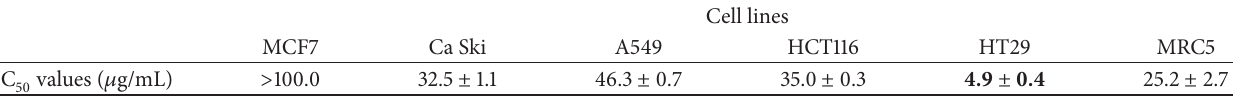
Table 2: Cytotoxicity activity of the rhizome oil of temu tis .